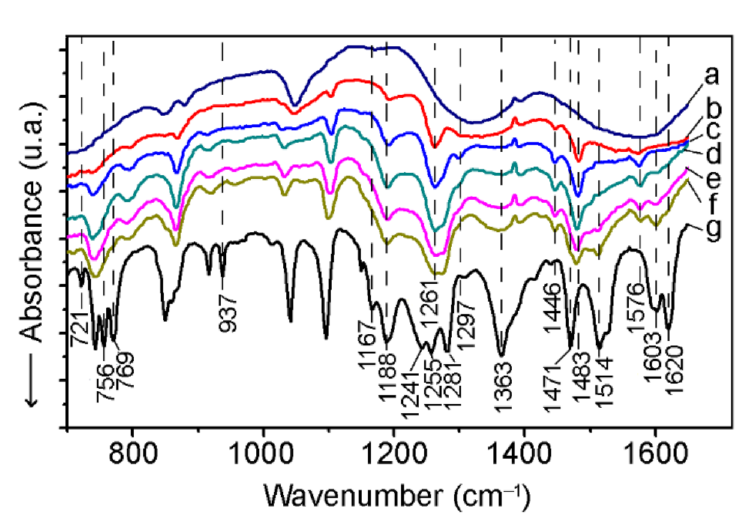
Figure 1. Fourier transform-infrared (FT-IR) spectra of pure CeO 2 (a), samples of P/CeO 2 with different contents of FA (0.1: b; 0.3: c; 0.6: d; 0.9: e; 1.2 mmol/g: f) and pure P